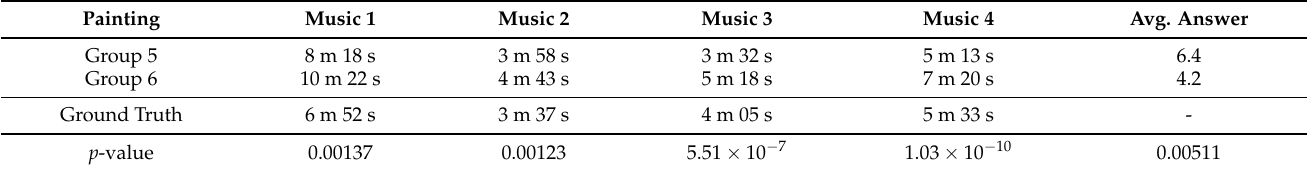
Table 9. Results of immersion experiments for assessing time distortion and cognitive absorption. A t -test was performed with the assumption of different